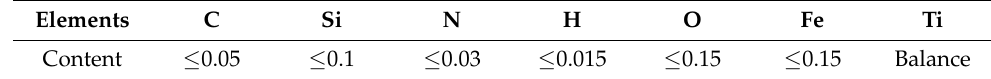
Table 1. Chemical compositions of TA1 titanium (wt. %).